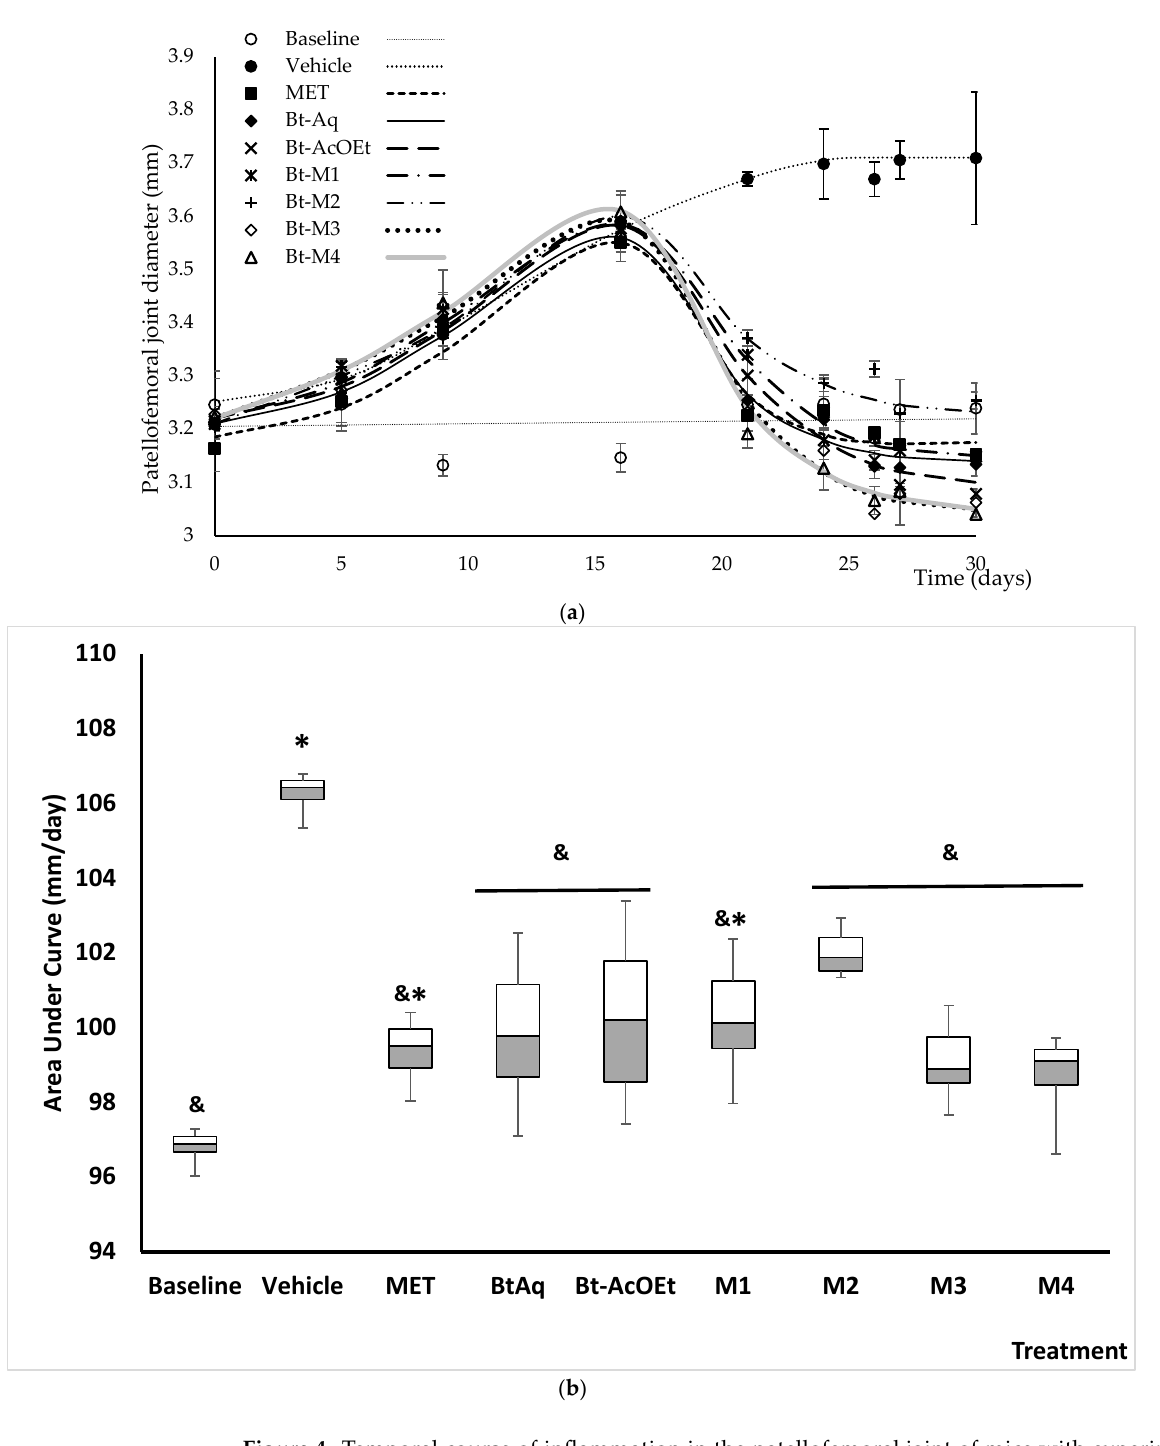
Figure 4. Temporal course of inflammation in the patellofemoral joint of mice with experimental arthritis ( a ) under the different treatments obtained from the B. ternifolia extract. The area under the curve (AUC) of the temporal course of the patellofemoral joint inflammation evolution and the effect of different experimental treatments obtained from B. ternifolia extract applied to mice with experimental arthritis ( b ). It is compared against the negative control groups or treatment with Vehicle ( & ) and basal control (*). The aqueous extract BtAq and the ethyl acetate extract, BtAcOEt, were derived from the bipartition of the complete extract. Fractions M1, M2, M3, and M4 were obtained from BtAcOEt. ANOVA with post hoc Tukey tests with * p < 0.05 compared with baseline group, & p < 0.05 compared with Veh group ( n = 7 ±